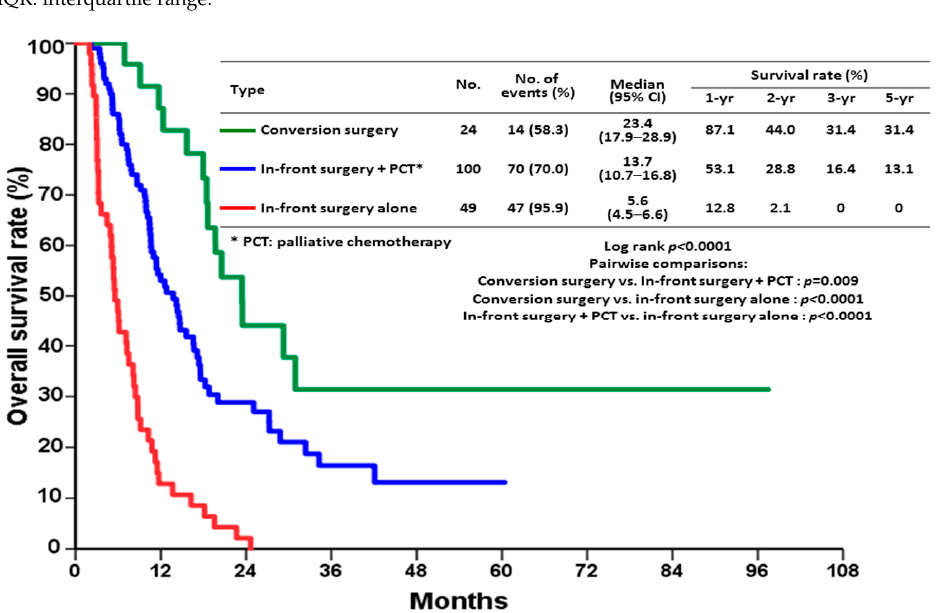
Figure 1. Kaplan–Meier survival curves in patients that underwent conversion surgery, in-front surgery plus palliative chemotherapy (PCT), and in-front surgery alone.